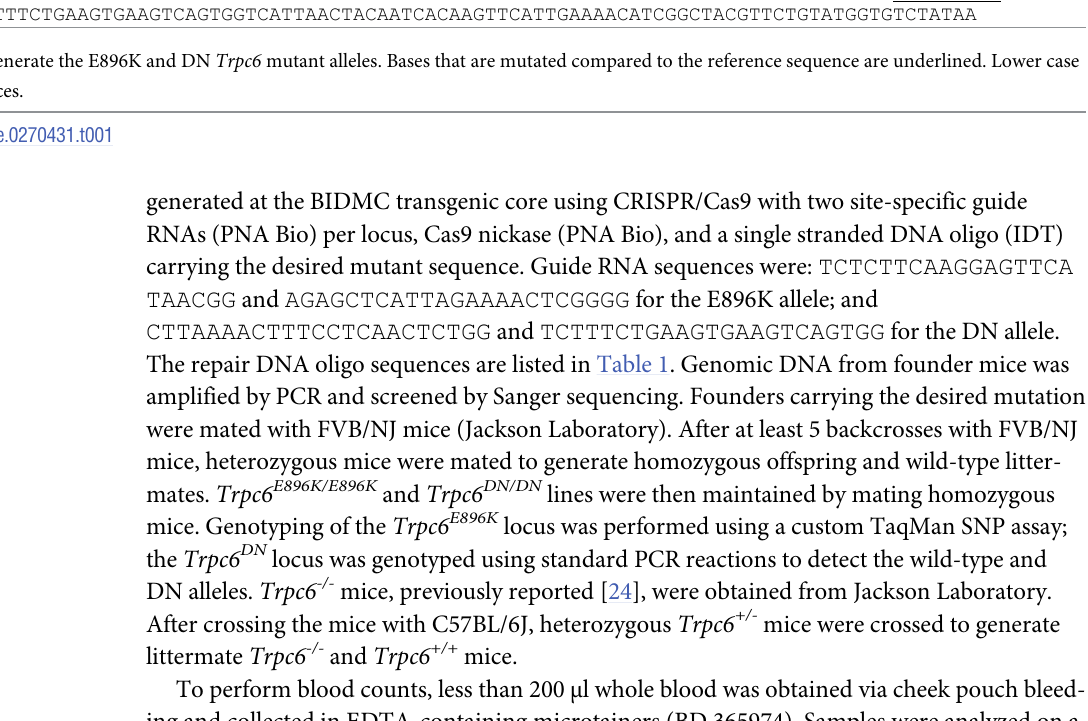
Repair oligo sequences used to generate the E896K and DN Trpc6 mutant alleles. Bases that are mutated compared to the reference sequence are underlined. Lower case letters represent intronic